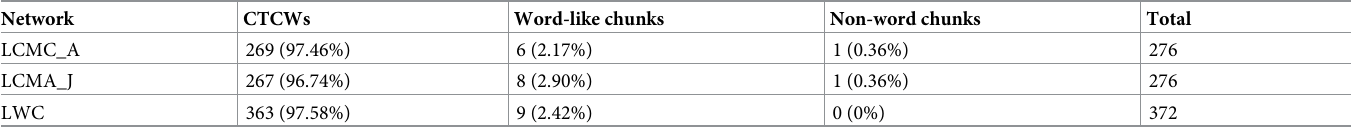
Table 1. Basic information of the TNIs extracted from the three